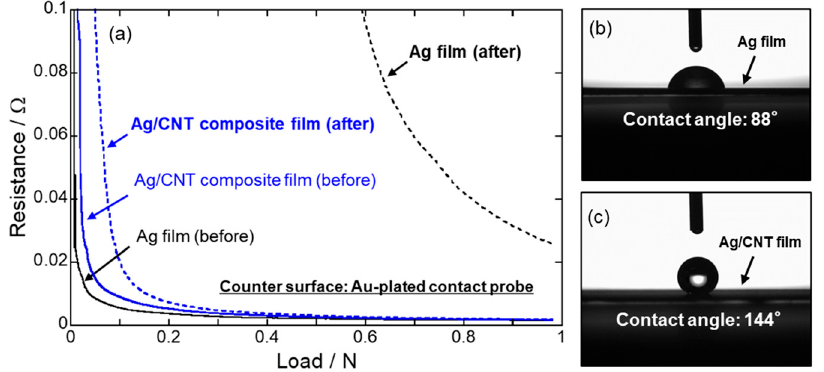
Figure 10. ( a ) Electrical contact resistance of Ag and Ag/CNT composite films before and after a sulfidation test. ( b ) and ( c ) are images of sessile water droplets on Ag film and Ag/MWCNT composite film, respectively. (Figure 10 is adapted from [103], Gold open access: CC BY-NC-ND 4.0, 2021).